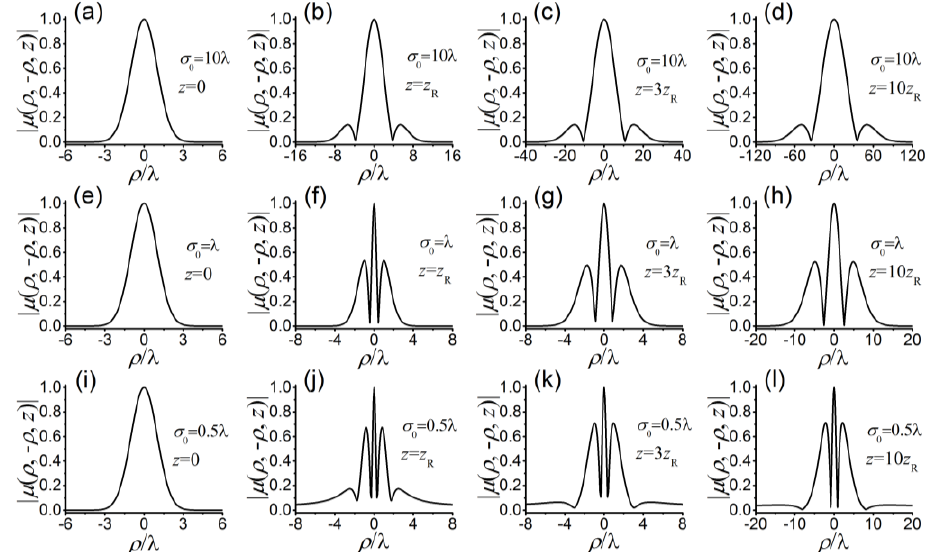
Figure 12. Modulus of SDOC | µ ( ρ , − ρ , z ) | (cross line at y = x ) of a nonparaxial PCRP beam with (cid:112) x 2 + y 2 and δ 0 = 2 λ at propagation distances z = 0 (first column), z = z R (second column), z = 3 z R (third column), z = 10 z R (fourth column) for the beam waist size σ 0 = 10 λ (first row), σ 0 = λ (second row), σ 0 = 0.5 λ (third row).